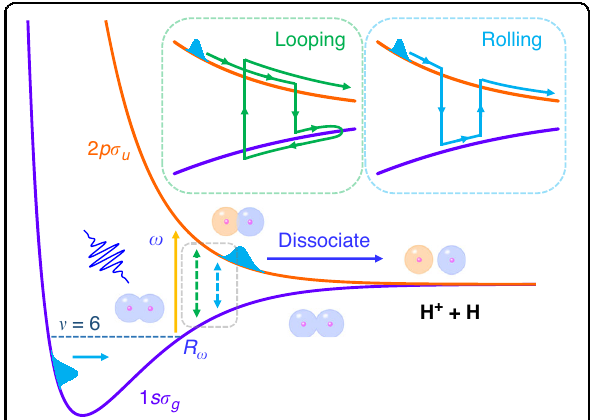
Fig. 1 Schematic illustration of dynamical Rabi coupling in strong- fi eld dissociation of H 2 + . Violet and orange curves denote the potential energy curves of the electronic ground (1 s σ g ) and excited (2 p σ u ) states, respectively. The yellow vertical arrow between the two curves indicates the resonant one-photon transition at R ω . The two insets sketch the looping and rolling processes during the molecular dissociation, marked by the gray frame. The dashed horizontal line marks the eigenenergy of the υ = 6 vibrational state on the 1 s σ g potential energy